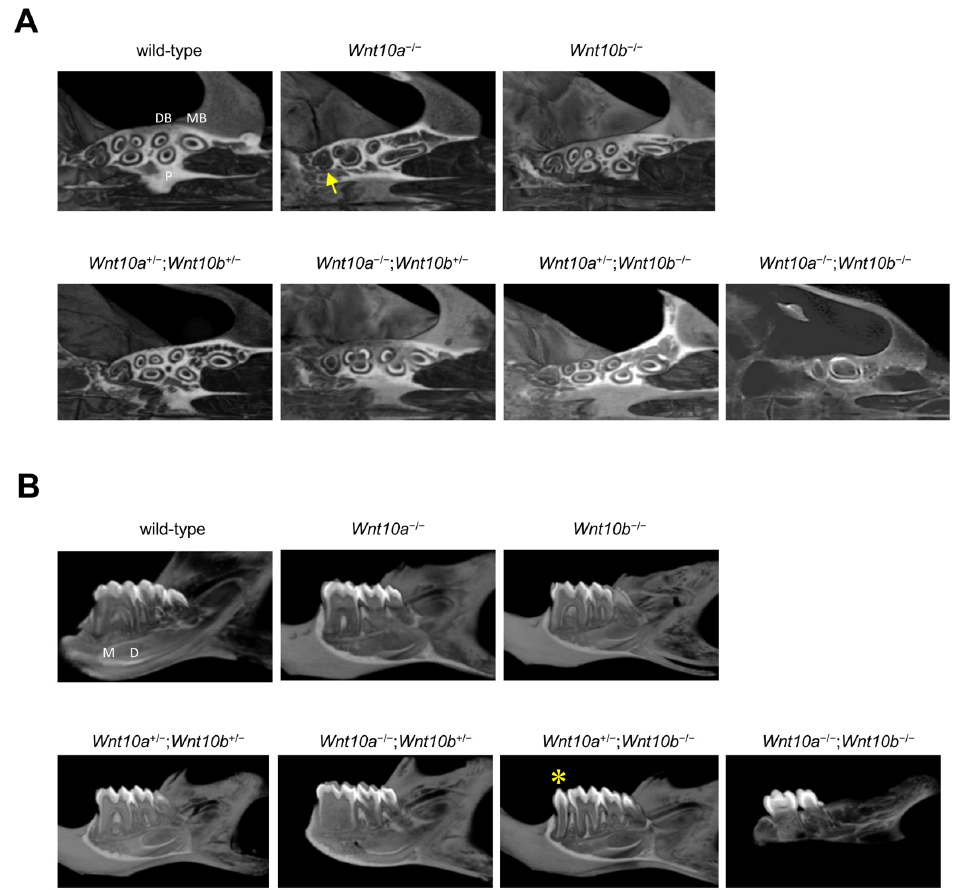
Figure 5. Molar root morphology of 4-week-old wild-type and mutant mice. Horizontal ( A ) and sagittal sections ( B ) of the right maxillary molars of wild-type and mutant mice. The arrow indicates a single root in maxillary M3, and the asterisk indicates a supernumerary tooth in